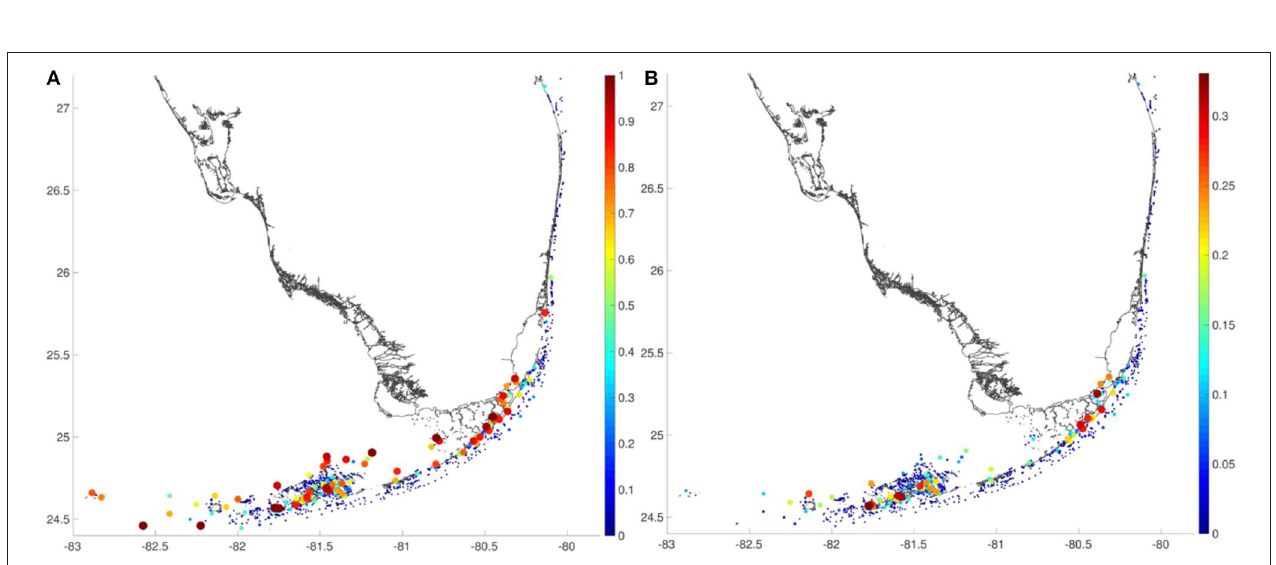
FIGURE 3 | (A) Self recruitment and (B) local retention on the whole FRT. Low self recruitment (and hence high isolation) are observed for the most upstream reefs and inside areas where topographical barriers can prevent larval transport. High local retention is observed inside the Lower Keys where small-scale flow features keep larvae near their source